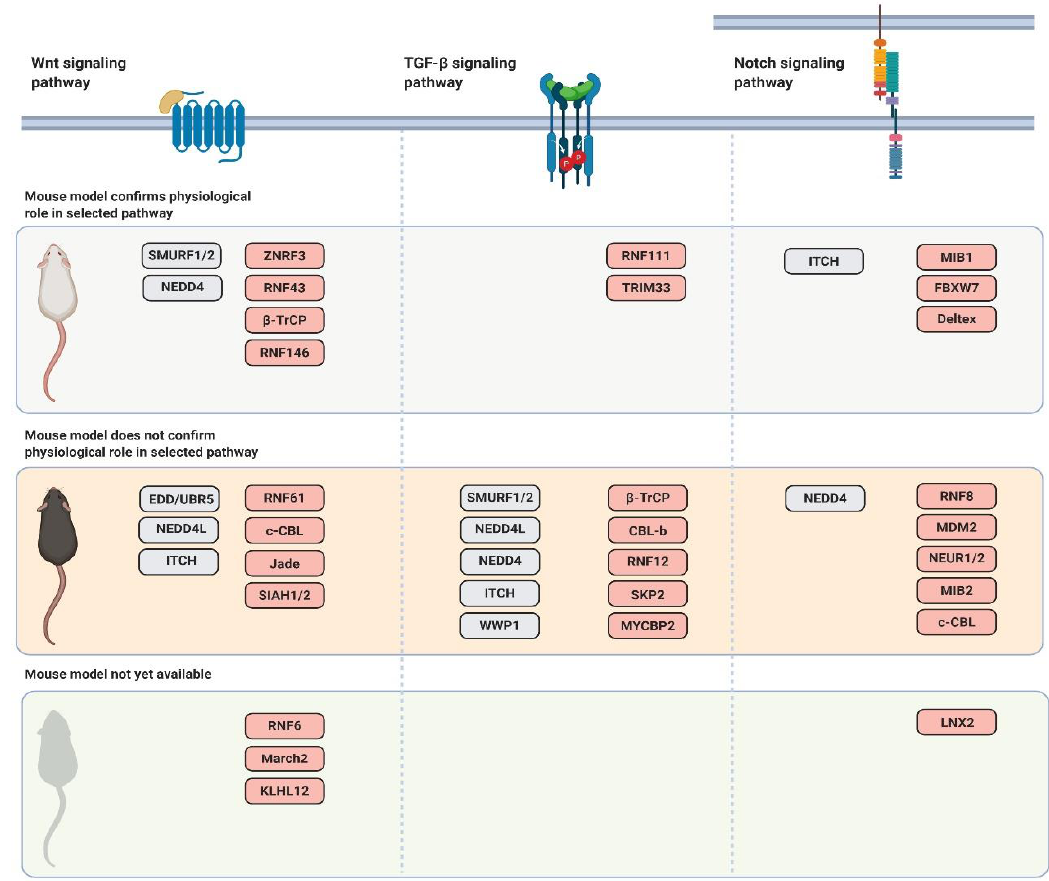
Figure 6. Schematic representation of mouse models of the selected ubiquitin ligases summarizing their physiological role in the Wnt, TGF- β , and Notch signaling pathways.